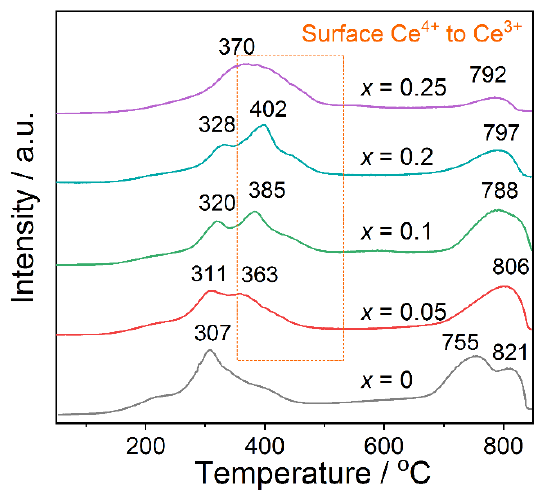
Figure 6. H 2 -TPR profiles of La 1- x Ce x MnO 3 (0 ≤ x ≤ 0.25) catalysts.